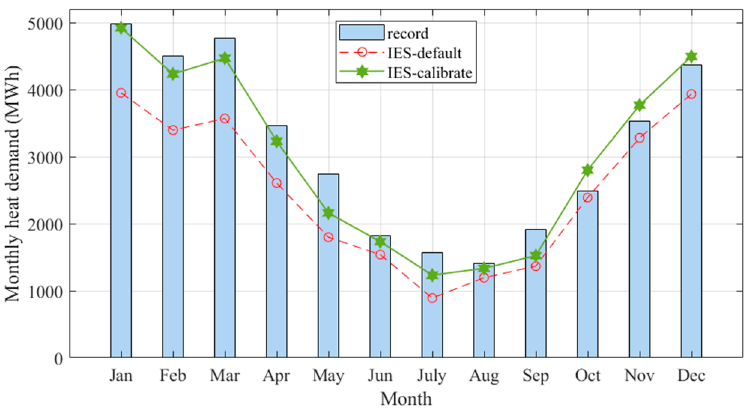
Figure 10. Prediction result using IES-VE comparing with recorded monthly heat demand. Table 4. Prediction result comparison among di ff erent number of parameters to be